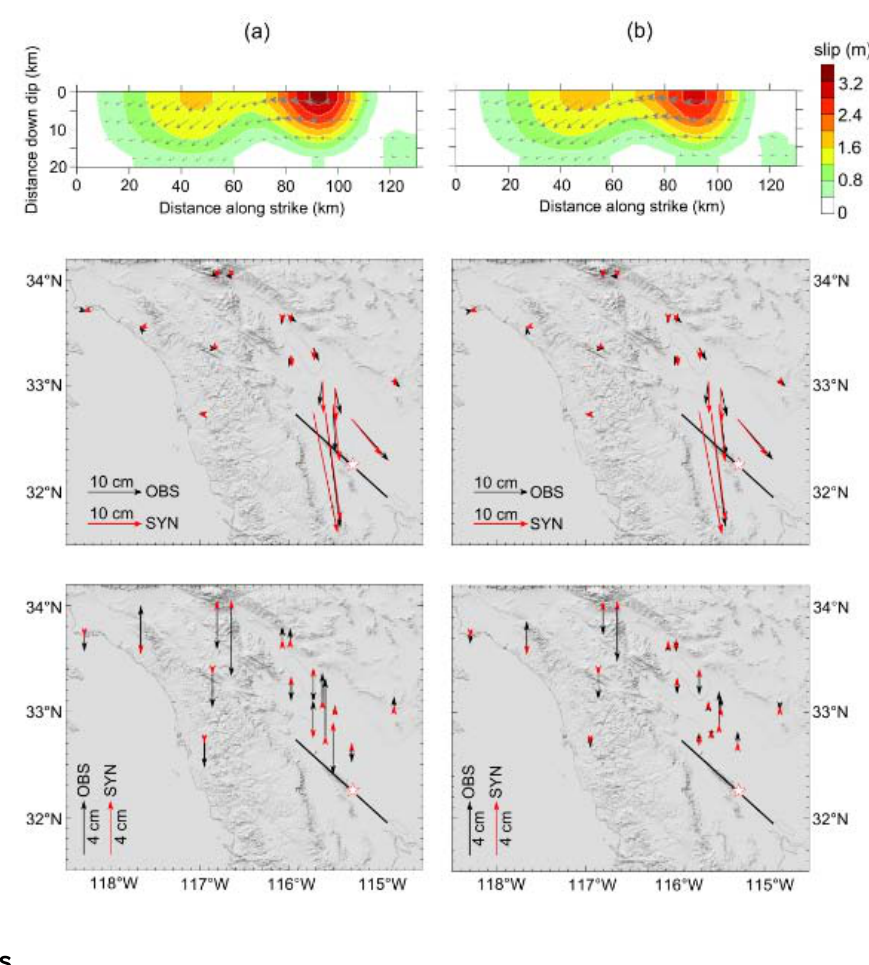
Figure 8. Fault slip inversion. ( a ) Inversion with permanent coseismic displacements obtained from real-time tightly-integrated solution; ( b ) Inversion with post-processed daily solution. From top to bottom are the inverted fault slip distributions, comparisons between the observed and the synthetic displacements on the horizontal components, and on the vertical components,